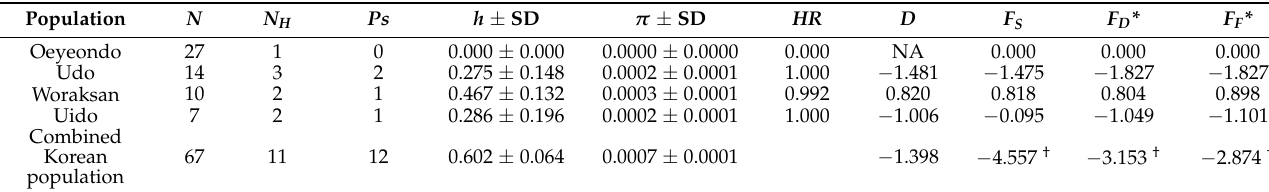
The four major populations in South Korea did not show significant neutrality test results, but the combined Korean population showed significant results for Fu’s F S , Fu and Li’s D* , and Fu and Li’s F* (Table 3). Although this population did not show a significant raggedness index for the observed mismatch distribution ( p = 0.111), the mismatch dis- tributions showed the typical unimodal shape with a small raggedness index (r =